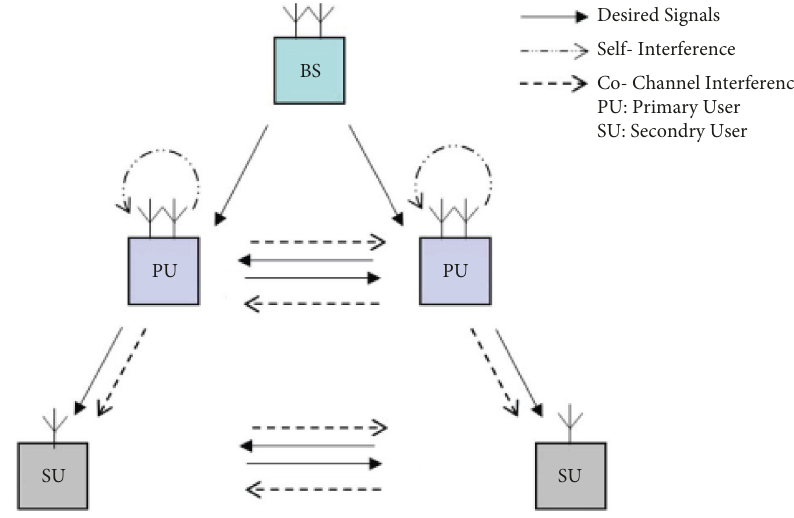
Figure 2: Schematic of the system model for